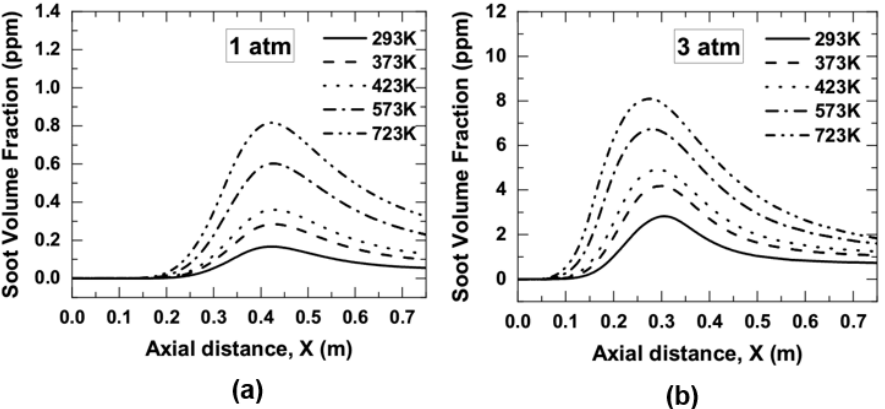
Figure 11. Centerline variation of soot volume fractions as a function of air preheat temperature; ( a ) 1 atm, and ( b ) 3 atm.